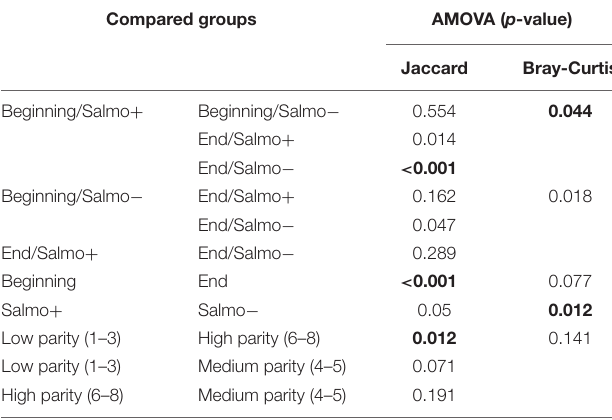
TABLE 4 | Beta-diversity analysis across sow groups and according to Salmonella shedding or time of gestation. Compared